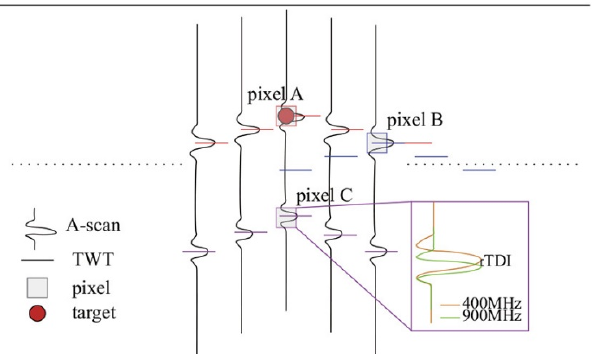
Figure 8. There is only one target at pixel A. However, the response of radar data can be found at pixel B and pixel C because of the diffraction and multiple reflections. The dashes beyond the radar signal are the TWT of pixels at each A-scan [15]. signal are the TWT of pixels at each A-scan